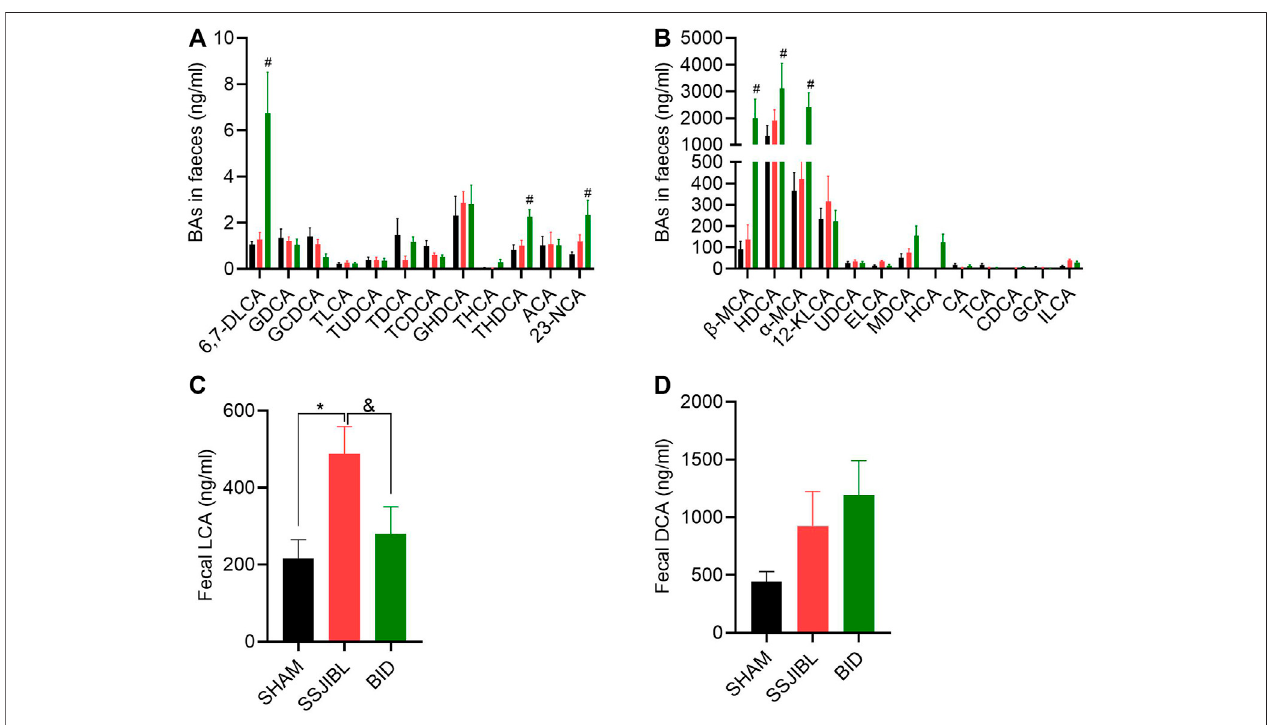
FIGURE 6 | Fecal BA composition. (A,B) Absolute values of each BA component in feces at days 14 after surgery. (C,D) Absolute values of LCA and DCA. ELCA, Epiallolithocholic Acid; ILCA, Isolithocholic Acid. # p < 0.05 for BID versus SHAM group; * p < 0.05 for SSJIBL versus SHAM group; & p < 0.05 for SSJIBL versus BID group.